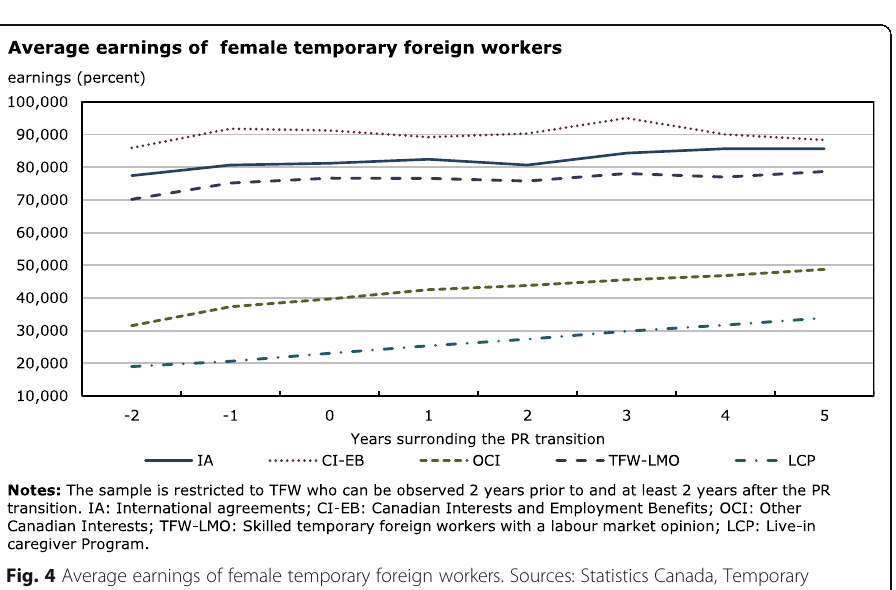
Fig. 4 Average earnings of female temporary foreign workers. Sources: Statistics Canada, Temporary Residents file, Immigrant Landing file and Canadian Employer-Employee Dynamics Database